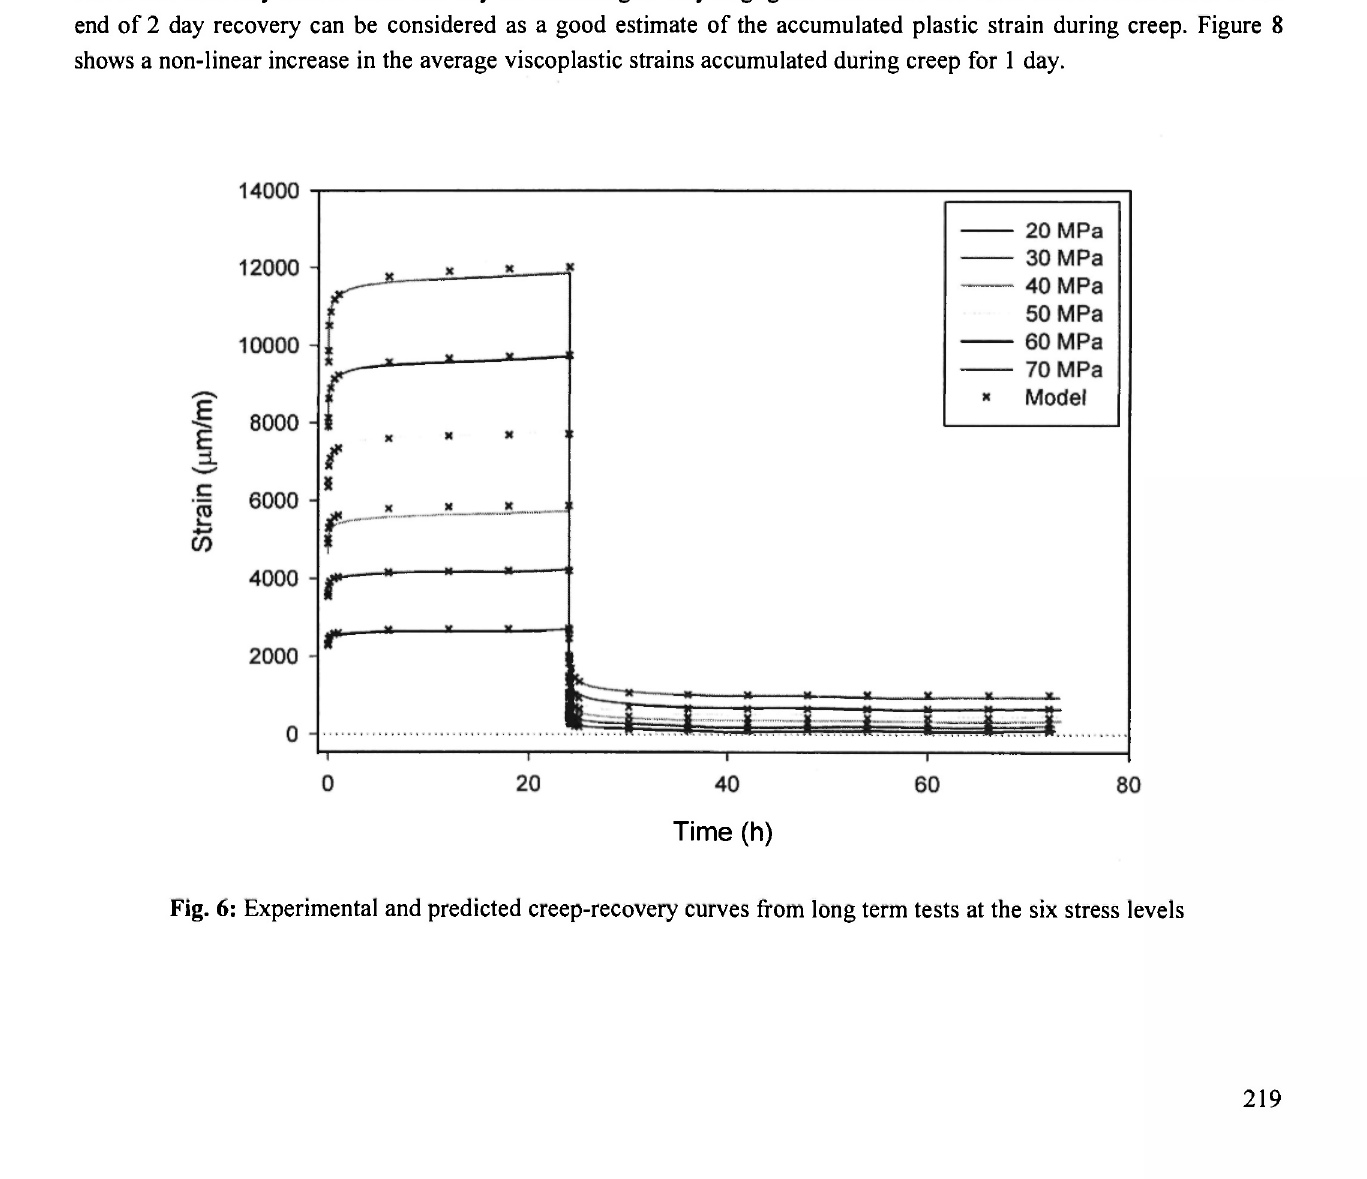
Fig. 6: Experimental and predicted creep-recovery curves from long term tests at the six stress